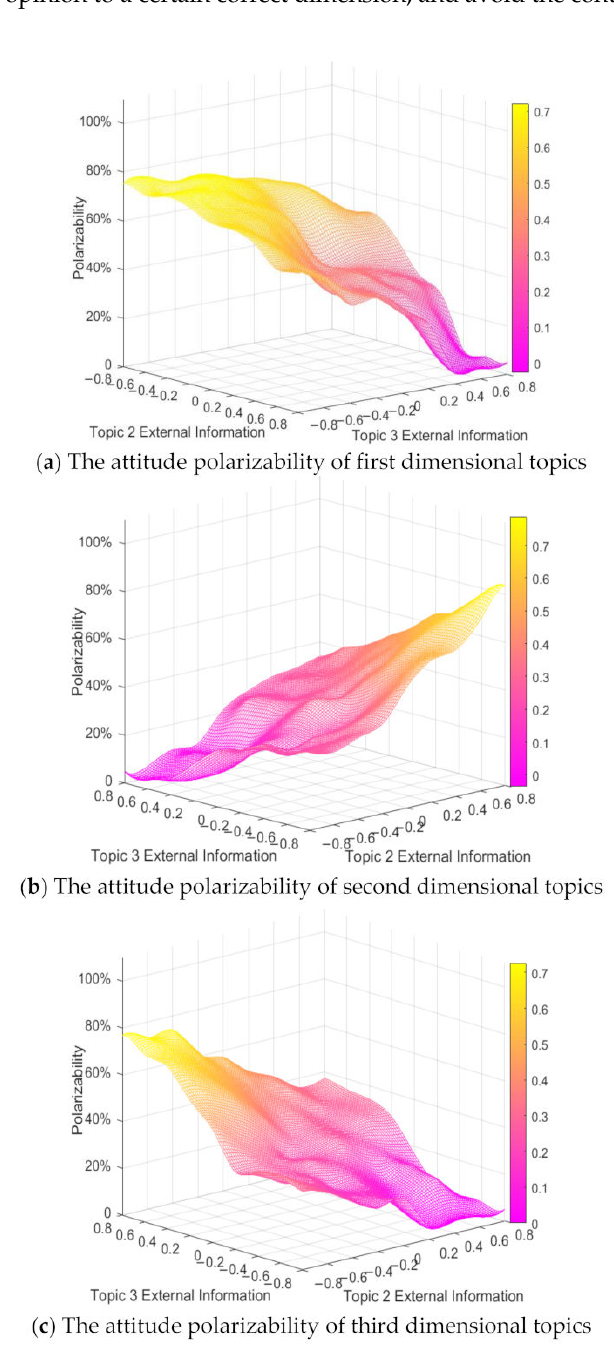
Figure 20. The attitude polarizability of external information intervention in topic 2 and topic 3 at different